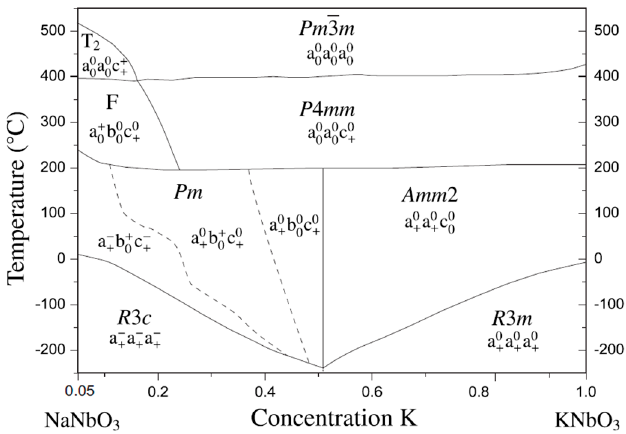
Figure 2. Phase diagram for the system KNbO 3 –NaNbO 3 . Adapted from [32], with permission from © 2009 AIP Publishing LLC.